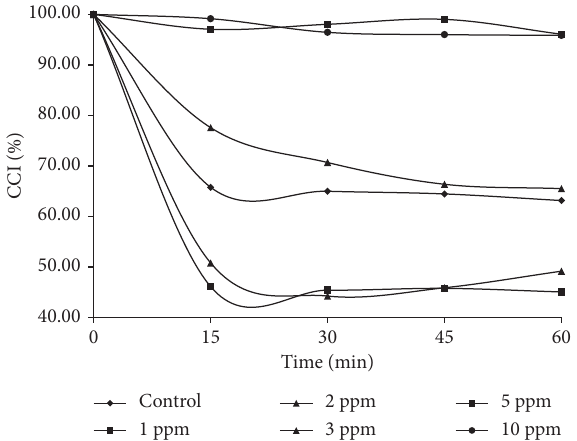
Figure 3: Influence of UV radiation on the ATMP concentrations on calcium carbonate scale inhibition, as a function of time.